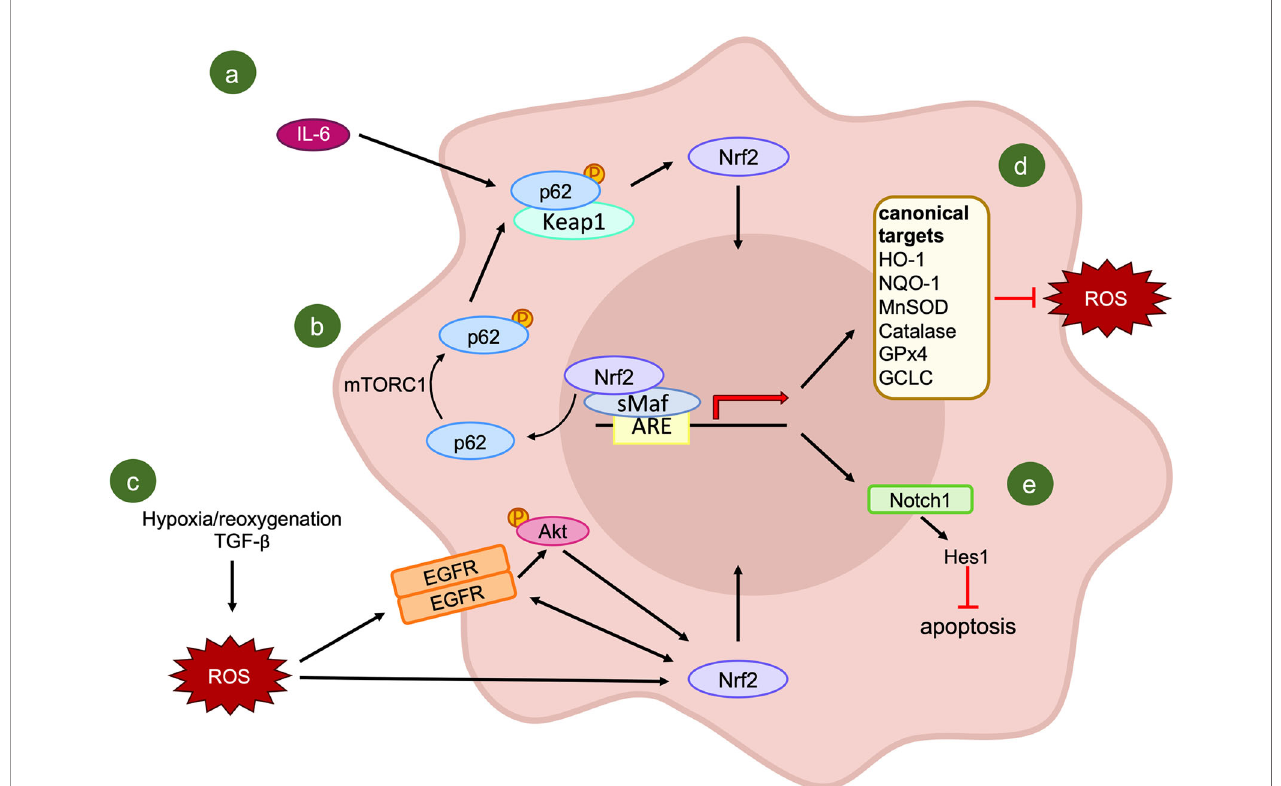
FIGURE 4 | Activators and effectors of NRF2 signaling pathway following IR exposure. (A, B) KEAP1-dependent activation of NRF2: IL-6 induces an increase in the phosphorylated form of p62, which combines with the NRF2 inhibitor KEAP1, leading to the release and translocation of NRF2 into the nucleus (A) ; (B) evidence of mTORC1 involvement in p62 phosphorylation. (C) A putative KEAP1-independent mechanism of NRF2 activation. (D) Canonical transcriptional targets of NRF2; (E) NRF2-mediated regulation of NOTCH1